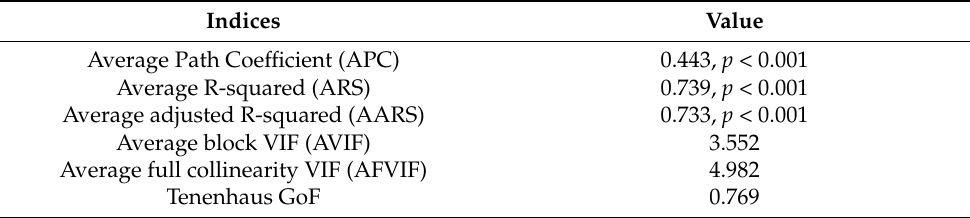
Table 5. Model efficiency